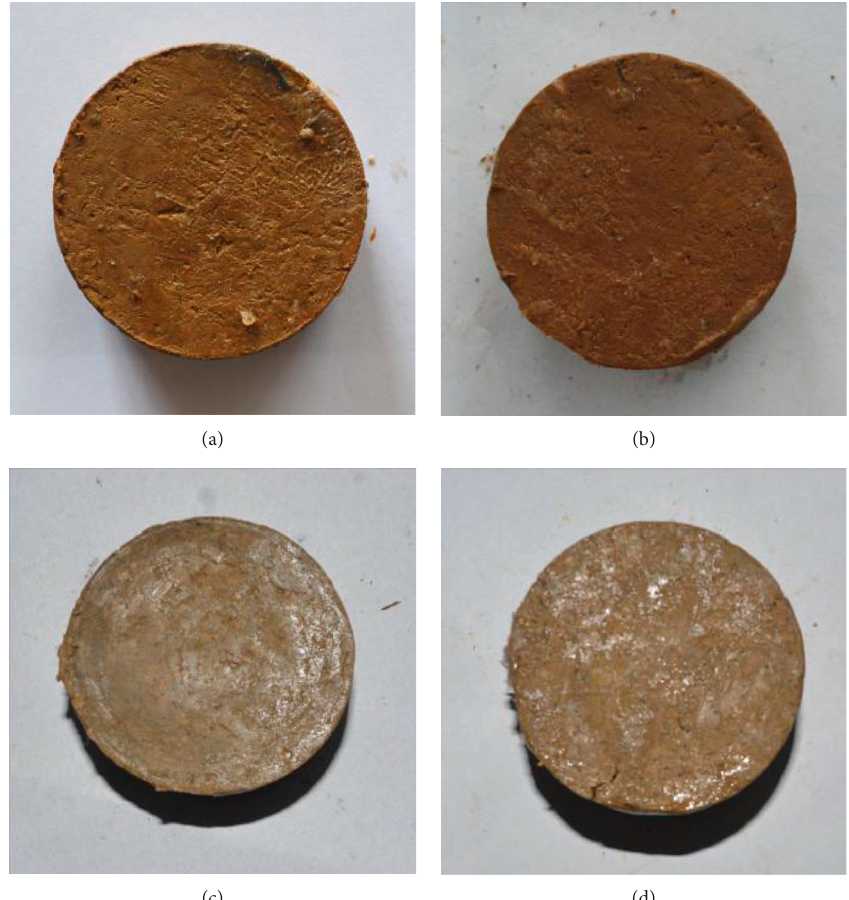
Figure 9: The failure modes of frozen soil of three groups under different test conditions. (a) Confining pressure of 0.5MPa, − 5 ° C, Group A. (b) Confining pressure of 0.5 MPa, − 15 ° C, Group A. (c) Confining pressure of 0.5MPa, − 5 ° C, Group C. (d) Confining pressure of 0.5MPa, − 15 ° C, Group